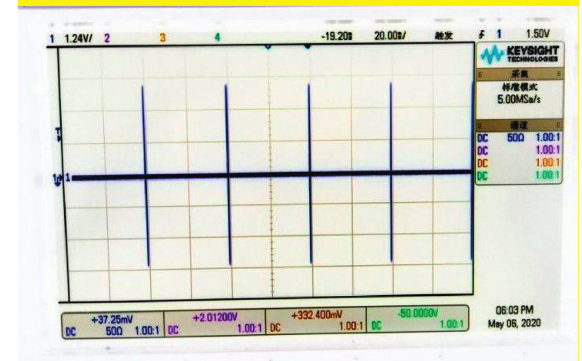
Figure 9: Photograph of 200ms detection